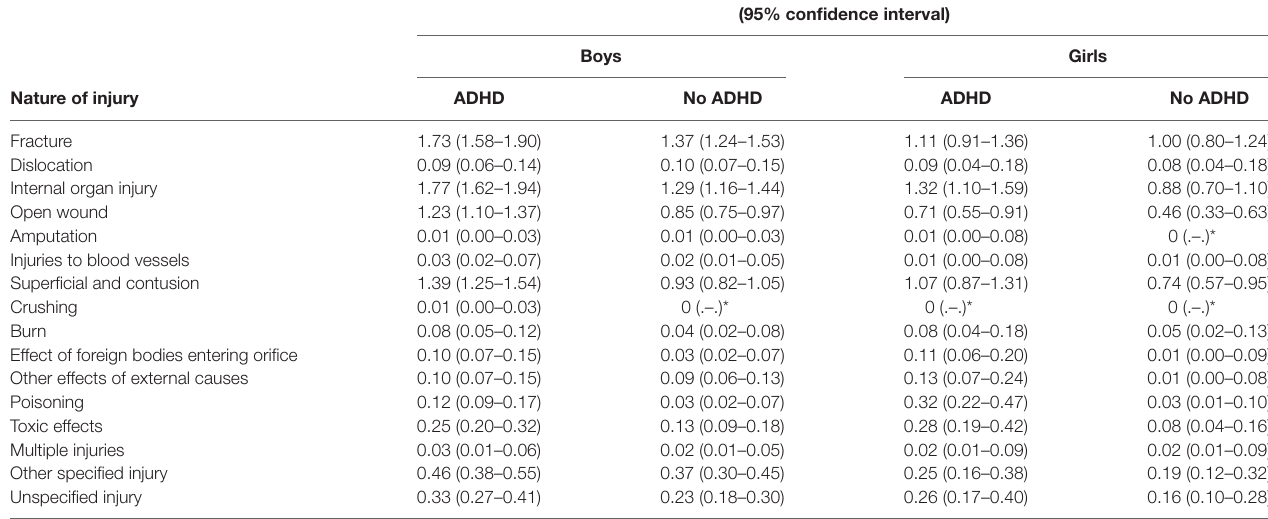
TaBle 1 | Estimated % experiencing hospitalizations with injury diagnoses during follow-up of 36 months, by nature of injury. a % experiencing hospitalizations with injury diagnoses during individual follow-up (95% confidence interval) Boys girls nature of injury aDhD no aDhD aDhD Fracture